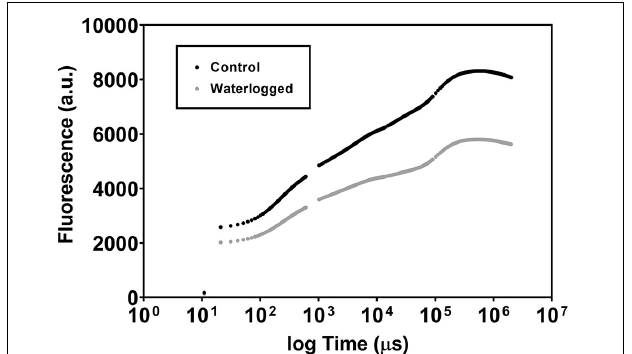
FIGURE 2 | Chlorophyll transient kinetics (Kautsky plots) in leaves of control plants (dark gray) and waterlogged plants (light gray) of Spartina patens after 30 days (mean ± s.d., n =